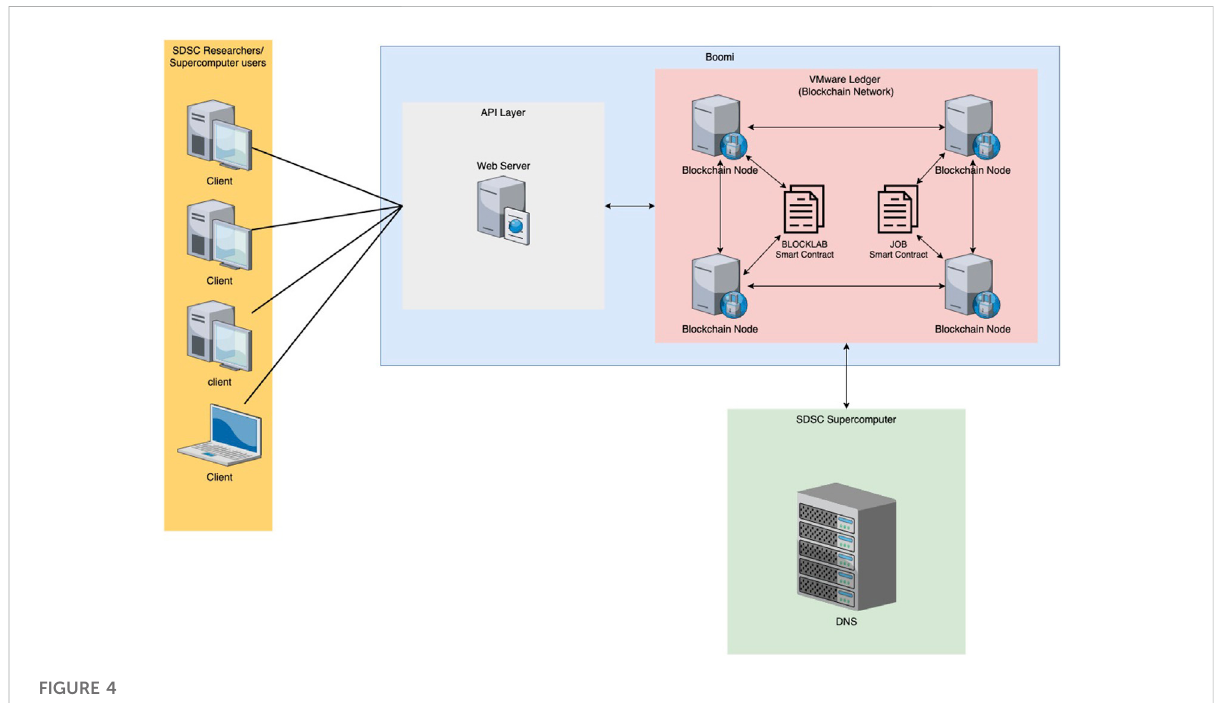
FIGURE 4 System under